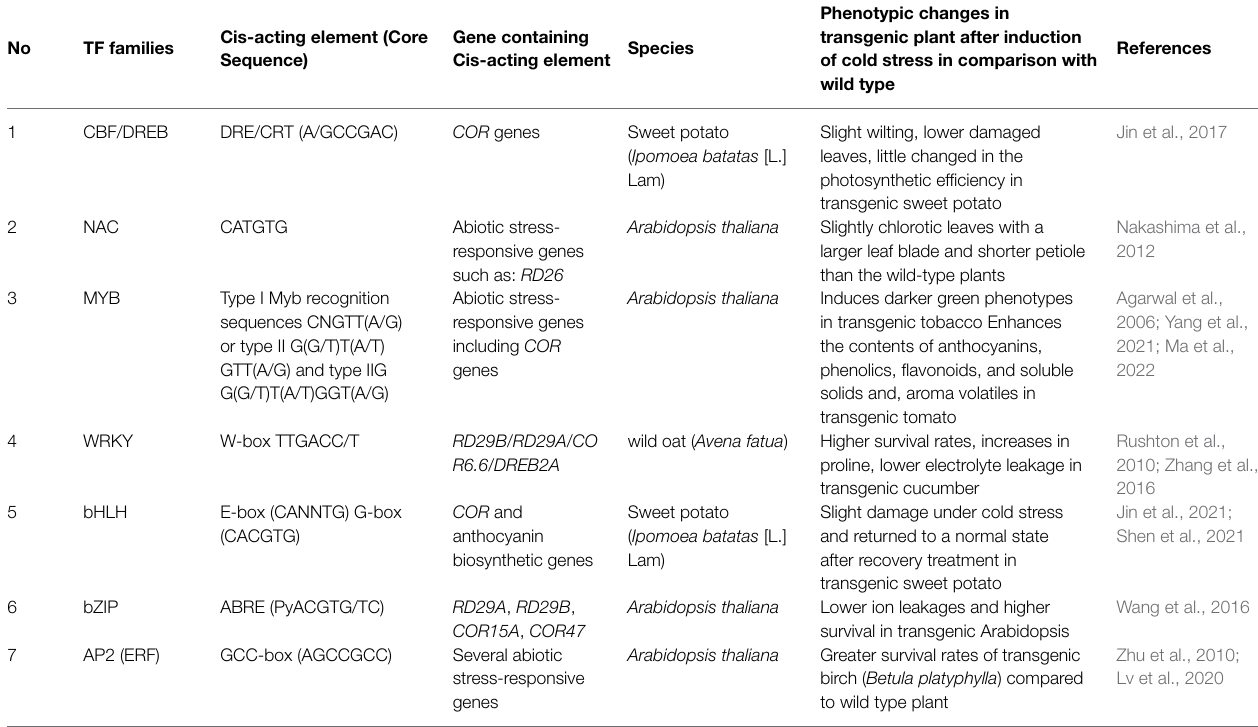
TABLE 1 | Transcription factor, cis-acting elements, and the corresponding responsive genes that are involved in plant abiotic